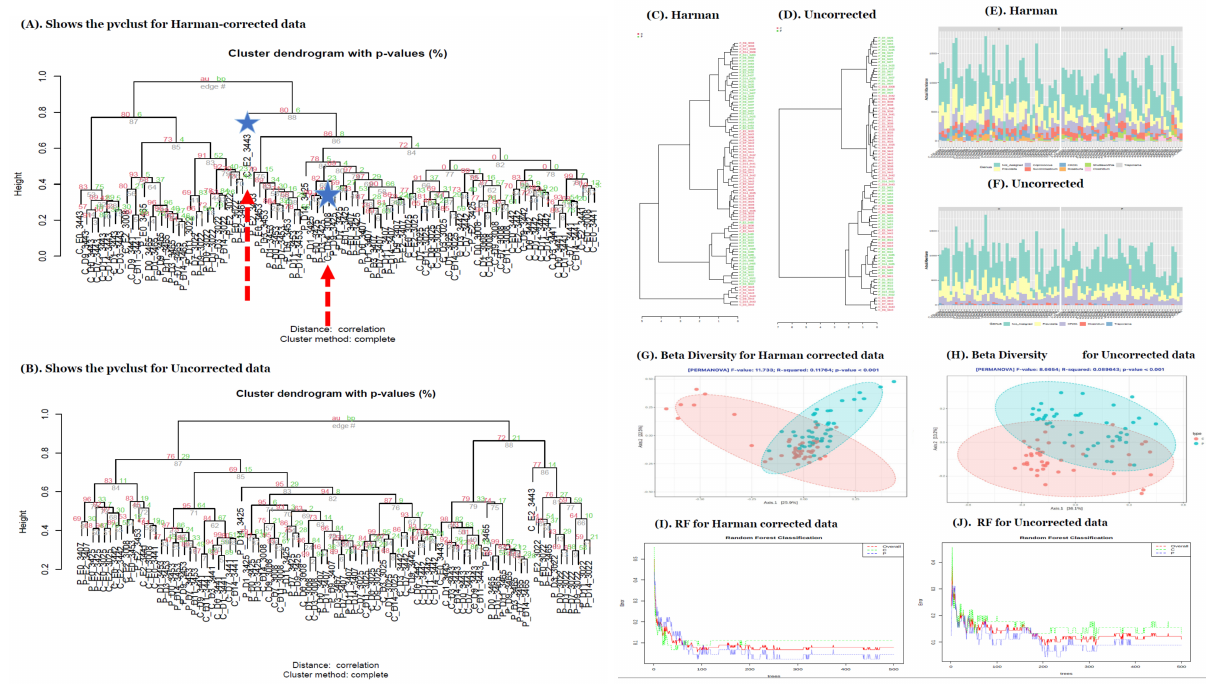
Figure 5. ( A ) shows the pvclust for Harman-corrected data. AU p -value in red color represents the area calculated by multi-scale bootstrap resampling procedure, whereas BP value in green color represents the bootstrap probability. In general, BP value is less accurate than AU value and AU value is recommended to be selected in the package currently [26]. Note that Harman-corrected data present much tighter grouping clusters in intra-samples except in 3008 at D-14 and 3443 at E-2 subject (highlighted in stars) in control group on pvclust with complete [26], compared to Uncorrected data with more mixed-up patterns between two treatment groups to cluster samples in ( B ). ( B ) shows the pvclust for uncorrected data. AU p -value in red color represents the area calculated by multi-scale bootstrap resampling procedure, whereas BP value in green color represents the bootstrap probability. In general, BP value is less accurate than AU value and AU value is recommended to be selected in the package currently [26]. ( C – F ) show the dendrograms generated from MicrobiomeAnalyst [27,28] for Harman and uncorrected data in left panel and the abundance of taxonomy genus levels in right panel. The type C (red) and P (green) in ( C , D ) represent control and P drug target treatment group, respectively [27,28]. Note that the sample clustering in plot tree dendrograms is conducted by Ward method in MicrobiomeAnalyst [27,28]. ( G – J ) shows the β diversity profiling 2D-PCoA and classification performances for random forest generated from MicrobiomeAnalyst [27,28] in Harman (left panel) and uncorrected data (right panel), respectively. Type C and P represent the control and drug target treatment group, respectively. In β diversity profiling analyses, distance method is used by Bray–Curtis Index and statistical significance test is used by permutational MANOVA (PERMANOVA)